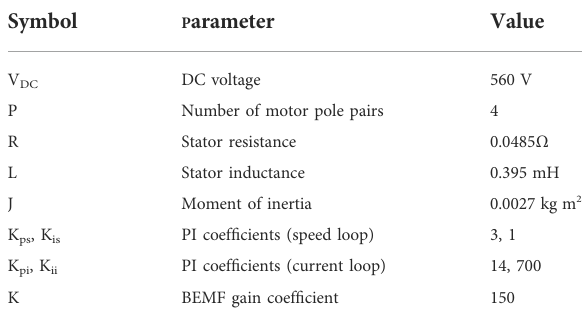
TABLE 1 Related parameters of the simulation model.